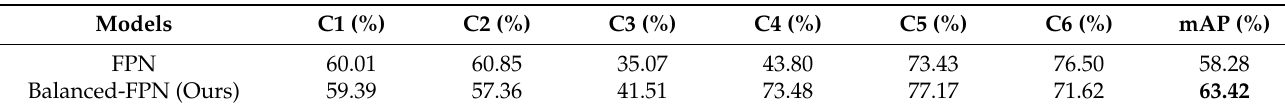
Table 5. Effectiveness of Balanced-FPN.